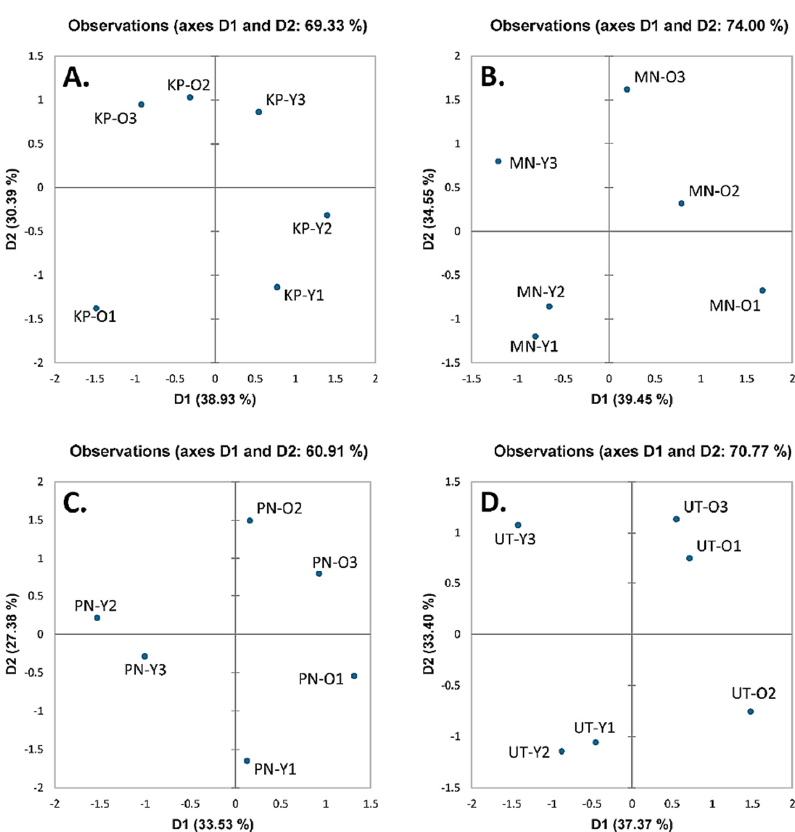
Figure 1. Observational plot of Principal Component Analysis (PCA) derived from mean of nutritive values, total phenolic contents, total flavonoid contents, and antioxidant activities in young shoots (Y) and old leaves (O) of Adenia viridiflora Craib. from different origins including ( A ) Kamphaeng Phet (KP); ( B ) Muang Nakhon Ratchasima (MN); ( C ) Pakchong Nakhon Ratchasima (PN); and ( D ) Uthai Thani (UT) collected in different harvesting periods including March–April (1), May–June (2), and July–August